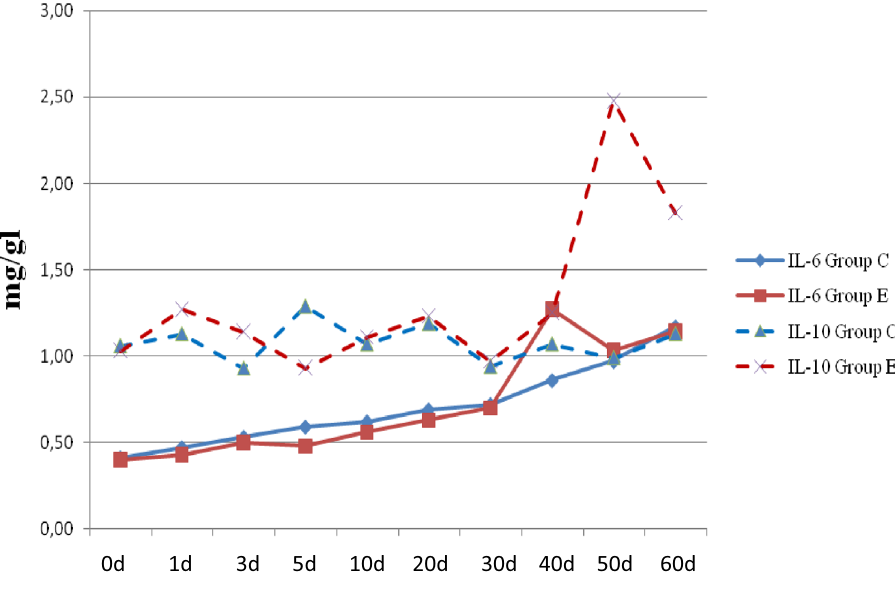
Figure 3. Influence of immunization on IL-6 and IL-10 concentration. 0d—sample collected at delivery; 1d—sample collected 24h after delivery; 3d—sample collected 3rd days of life; 5d—sample collected 5th days of life; 10d—sample collected 10th days of life; 20d—sample collected 20th days of life; 30d—sample collected 30th days of life; 40d—sample collected 40th days of life; 50d—sample collected 50th days of life;